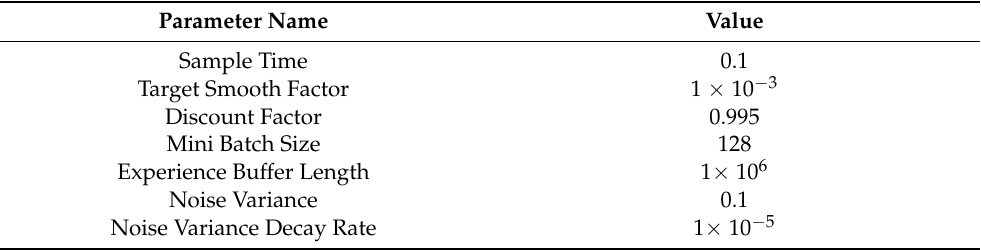
Table 3. DDPG Agent definition